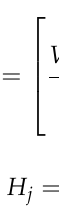
Figure 7. Representation of the analyzed cases and their degrees of freedom.